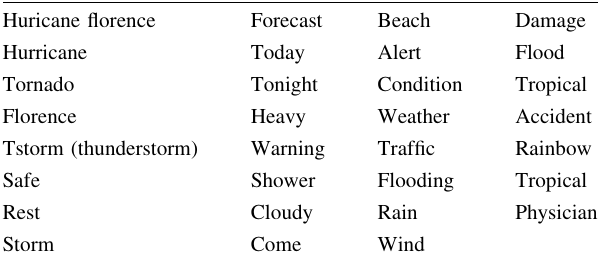
Table 5 List of keywords used to select important tweet clusters